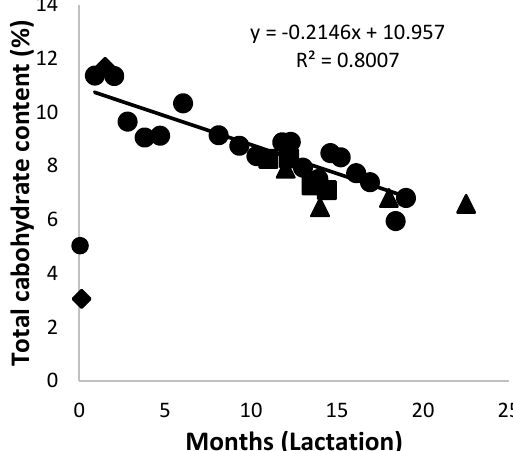
Figure 6. Changes of the total carbohydrates in milk of African elephants during lactation (Shorty ( • ), Bloem ( ♦ ) Mussina ( ■ ), and others ( ▲ )). The trend line for combined data of all animals was y = 0.0051x 2 + − 0.3381x + 11.444 and R 2 = 0.8214.